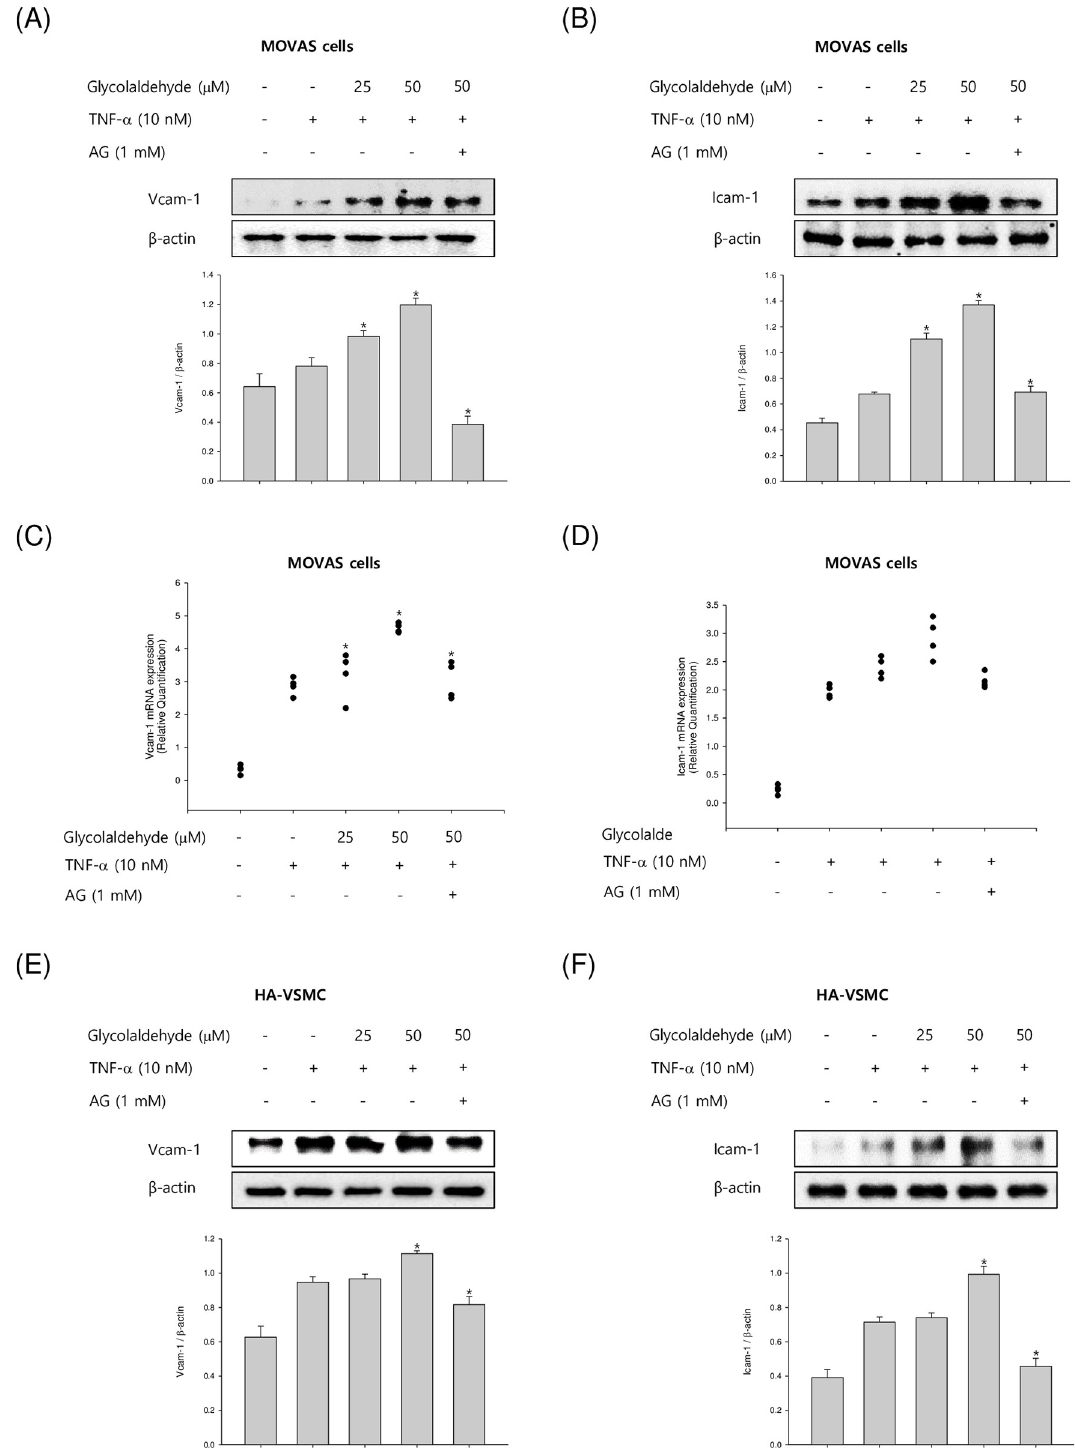
Fig 1. Effects of GA on TNF- α -stimulated adhesion molecule protein and mRNA levels in VSMCs. (A and B) The mouse VSMCs, MOVAS-1 cells, were incubated with TNF- α (10 ng/mL) in the presence or absence of GA (25 and 50 μ M) for 8 h. The CAM protein levels of whole cells were investigated by western blotting. (C and D) MOVAS-1 cells were stimulated with TNF- α (10 ng/mL) in the presence or absence of GA (25 and 50 μ M) for 4 h. The mRNA level of VCAM-1 and ICAM-1 was investigated by qRT-PCR. GAPDH served as the internal control. (E and F) The human primary cells, HA-VSMCs, were incubated with TNF- α (10 ng/mL) in